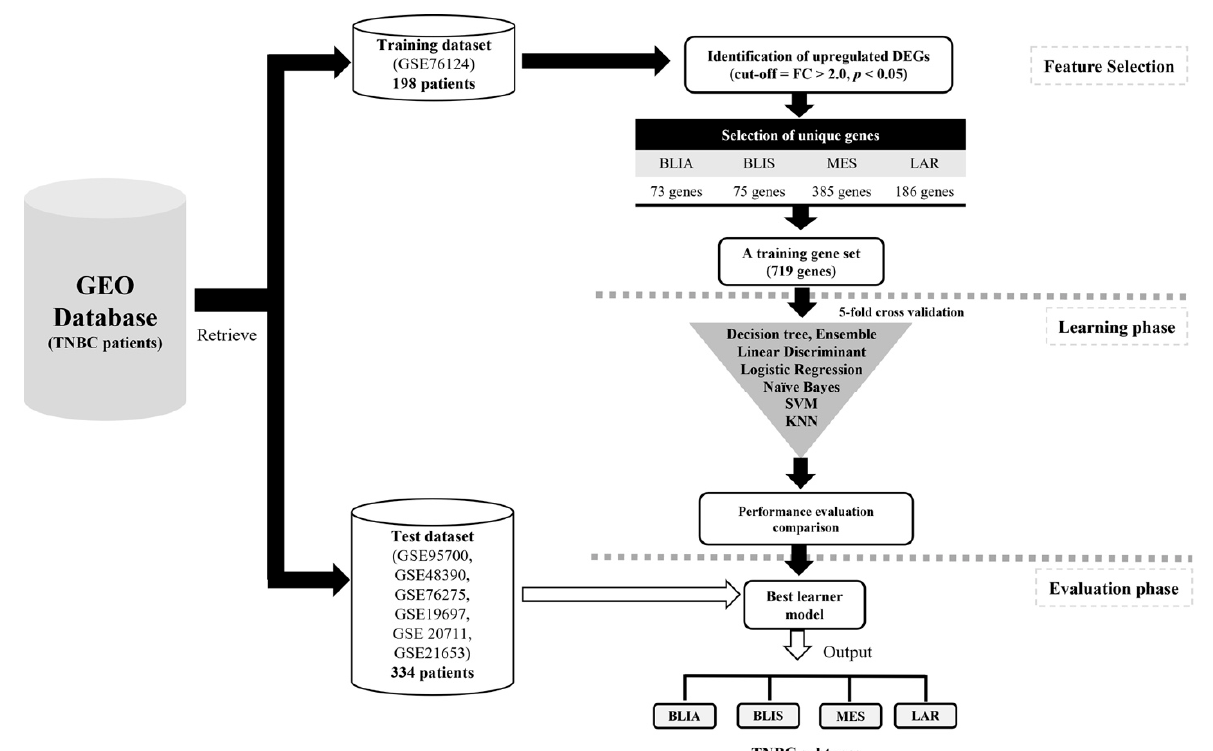
Figure 7. Machine learning analysis workflow for the classification of TNBC subtypes.